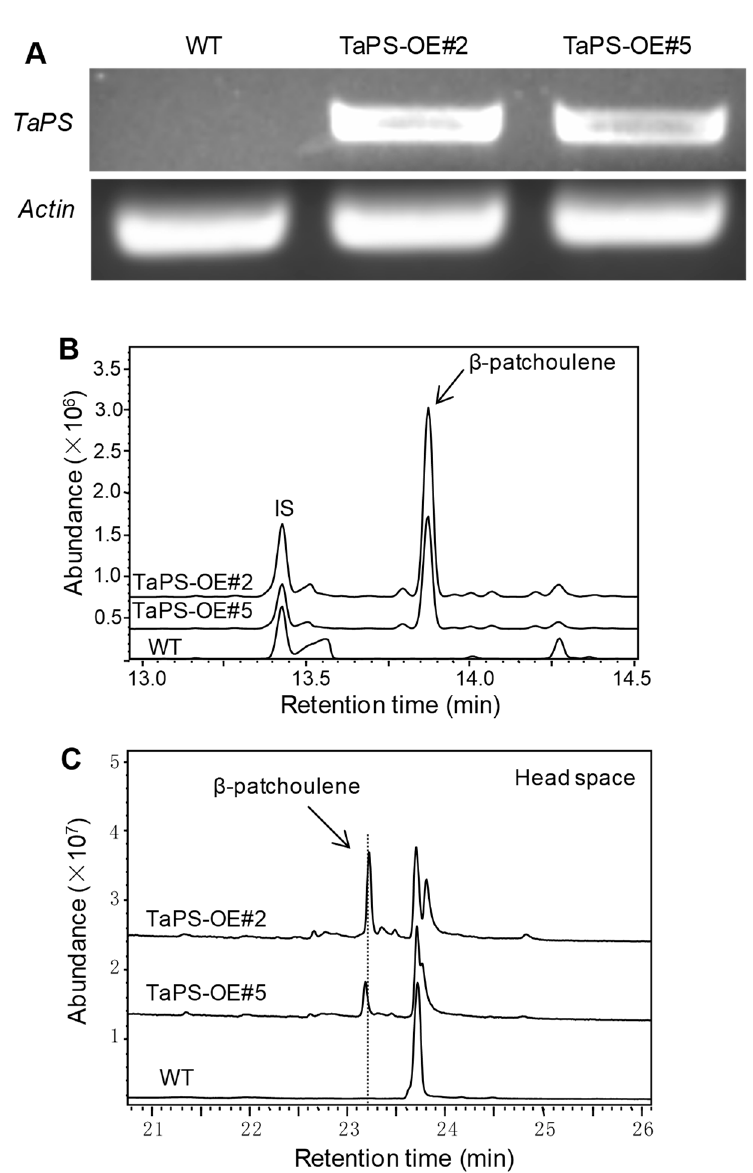
Figure 3. Overexpression of TaPS in Arabidopsis. ( A ) RT-PCR analysis of TaPS gene expression in transgenic Arabidopsis. Actin was used as the control gene; ( B ) GC-MS analysis of β -patchoulene production in two transgenic Arabidopsis lines (TaPS-OE#2 and #5). IS indicates the internal standard; ( C ) head space volatile analysis by GC-MS for TaPS transgenic Arabidopsis plants.